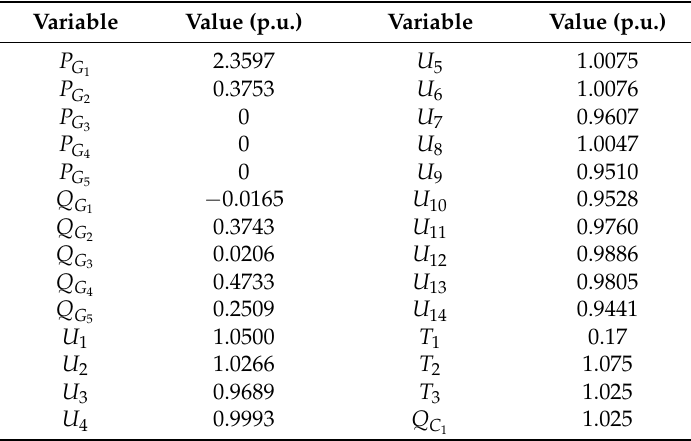
Table 6. Tested controlled variables of the IEEE 14-bus system.